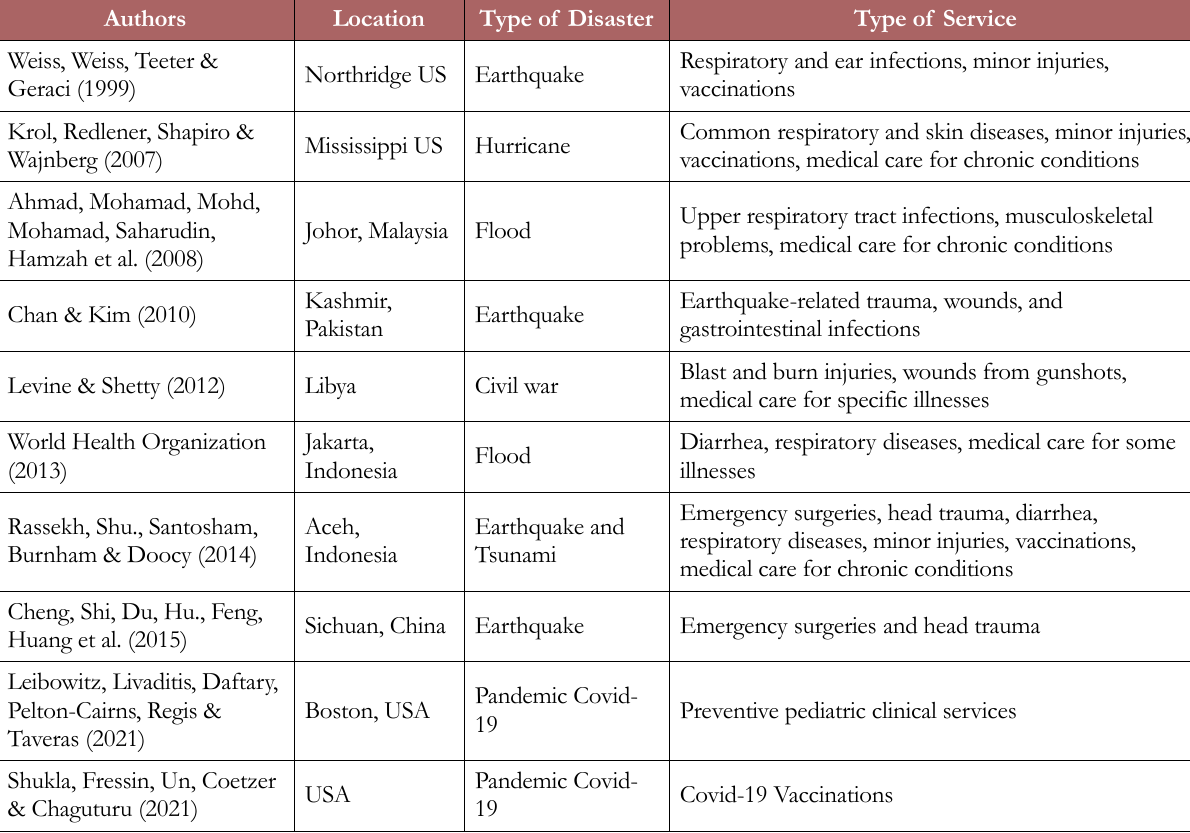
Table 1. Mobile Health Clinic Implementations during Disaster